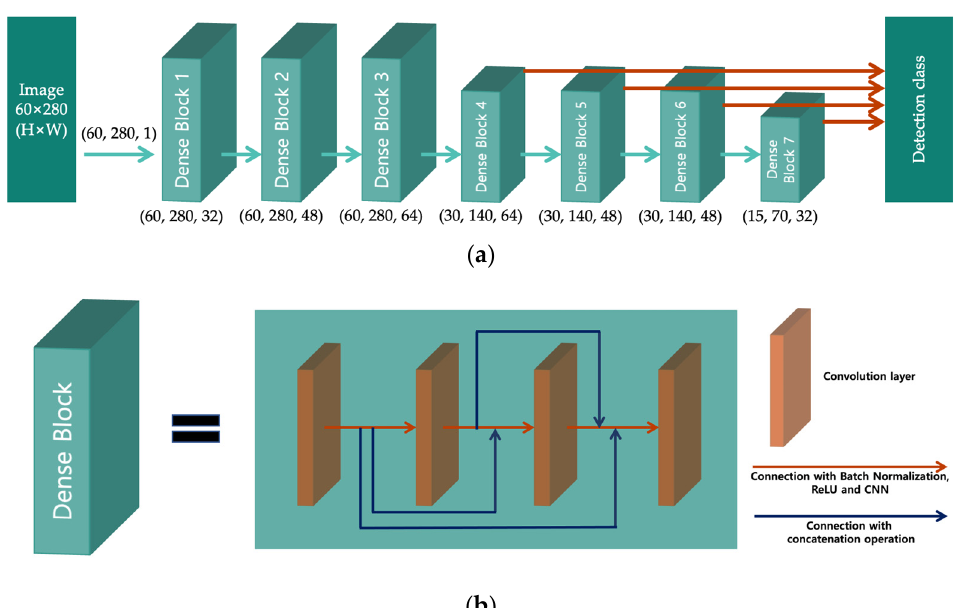
Figure 3. Single shot multi-box detector (SSD) based multi-currency integrated serial number recog‑